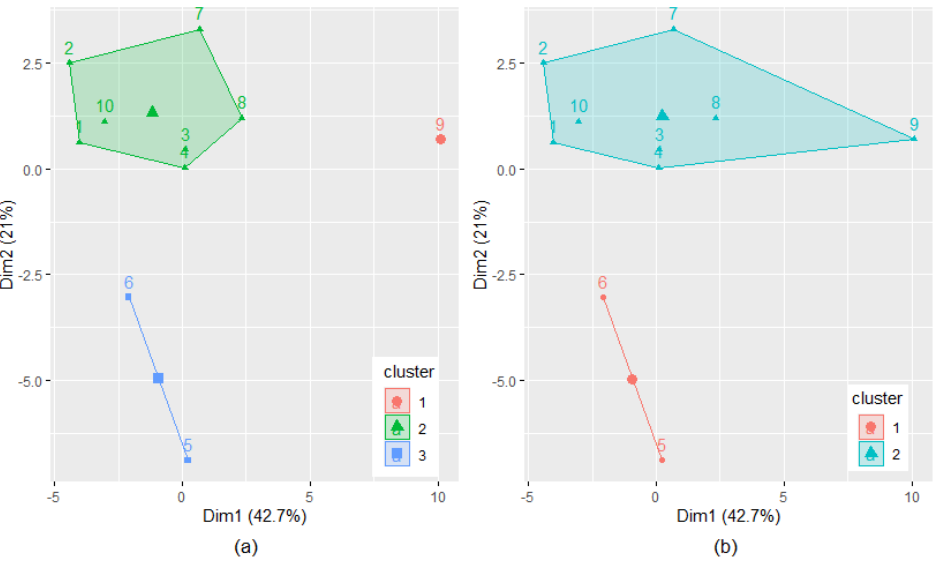
Figure 8. Clustering the data series: ( a ) three and ( b ) two clusters.